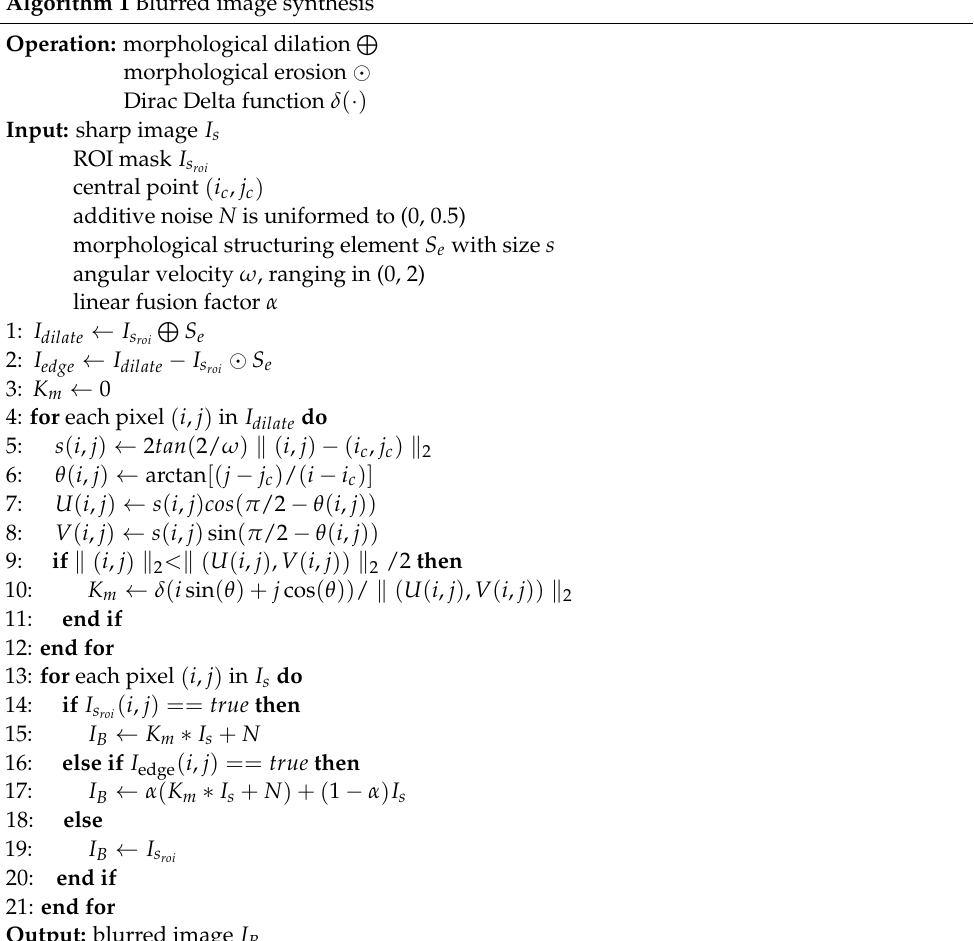
Algorithm 1 Blurred image synthesis